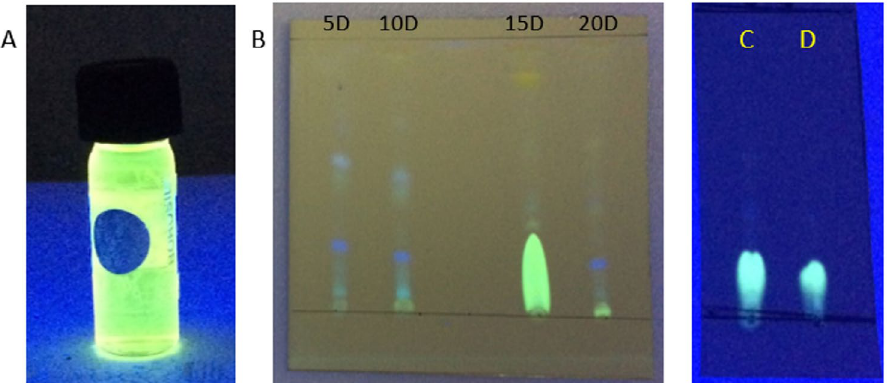
Fig. 4. (A) DCM extract of Penicillium sp. MIP-3 showing fluorescence. (B) TLC analysis of extracts harvested at different days (5 th , 10 th 15 th & 20 th day). (C) partially purified fraction resolved on pre-coated silica plates, (D) authentic riboflavin.